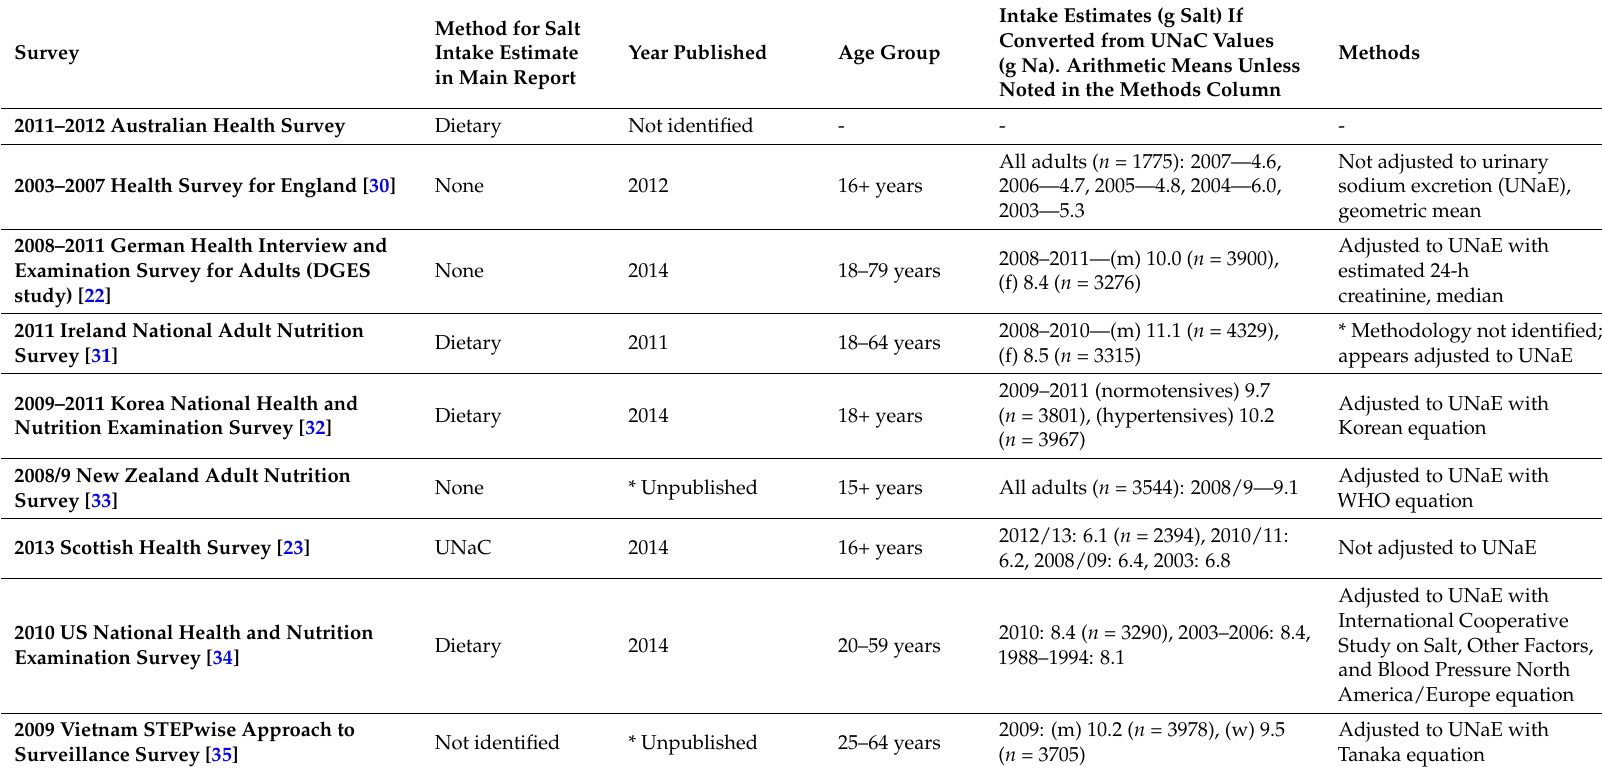
Table 1. Characteristics of National Surveys Collecting Casual Urinary Sodium Concentrations